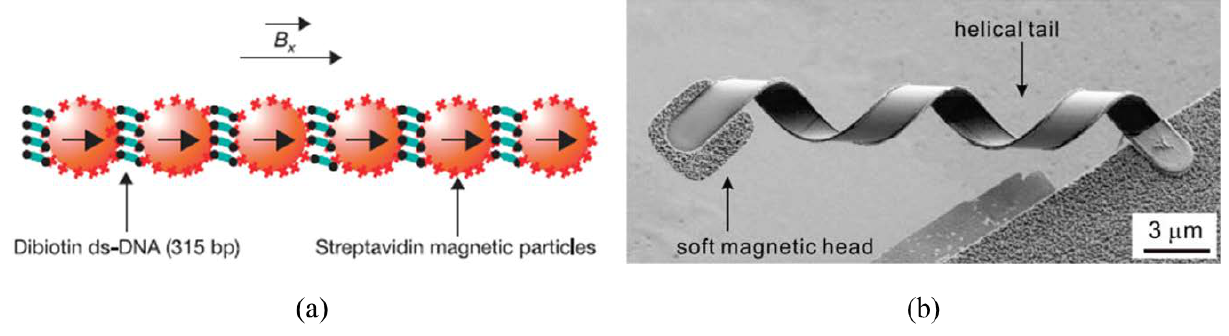
Figure 4. ( a ) Schematic of a DNA linked flexible magnetic filament [54]; ( b ) SEM image of ABF with diameter of 2.8 μm